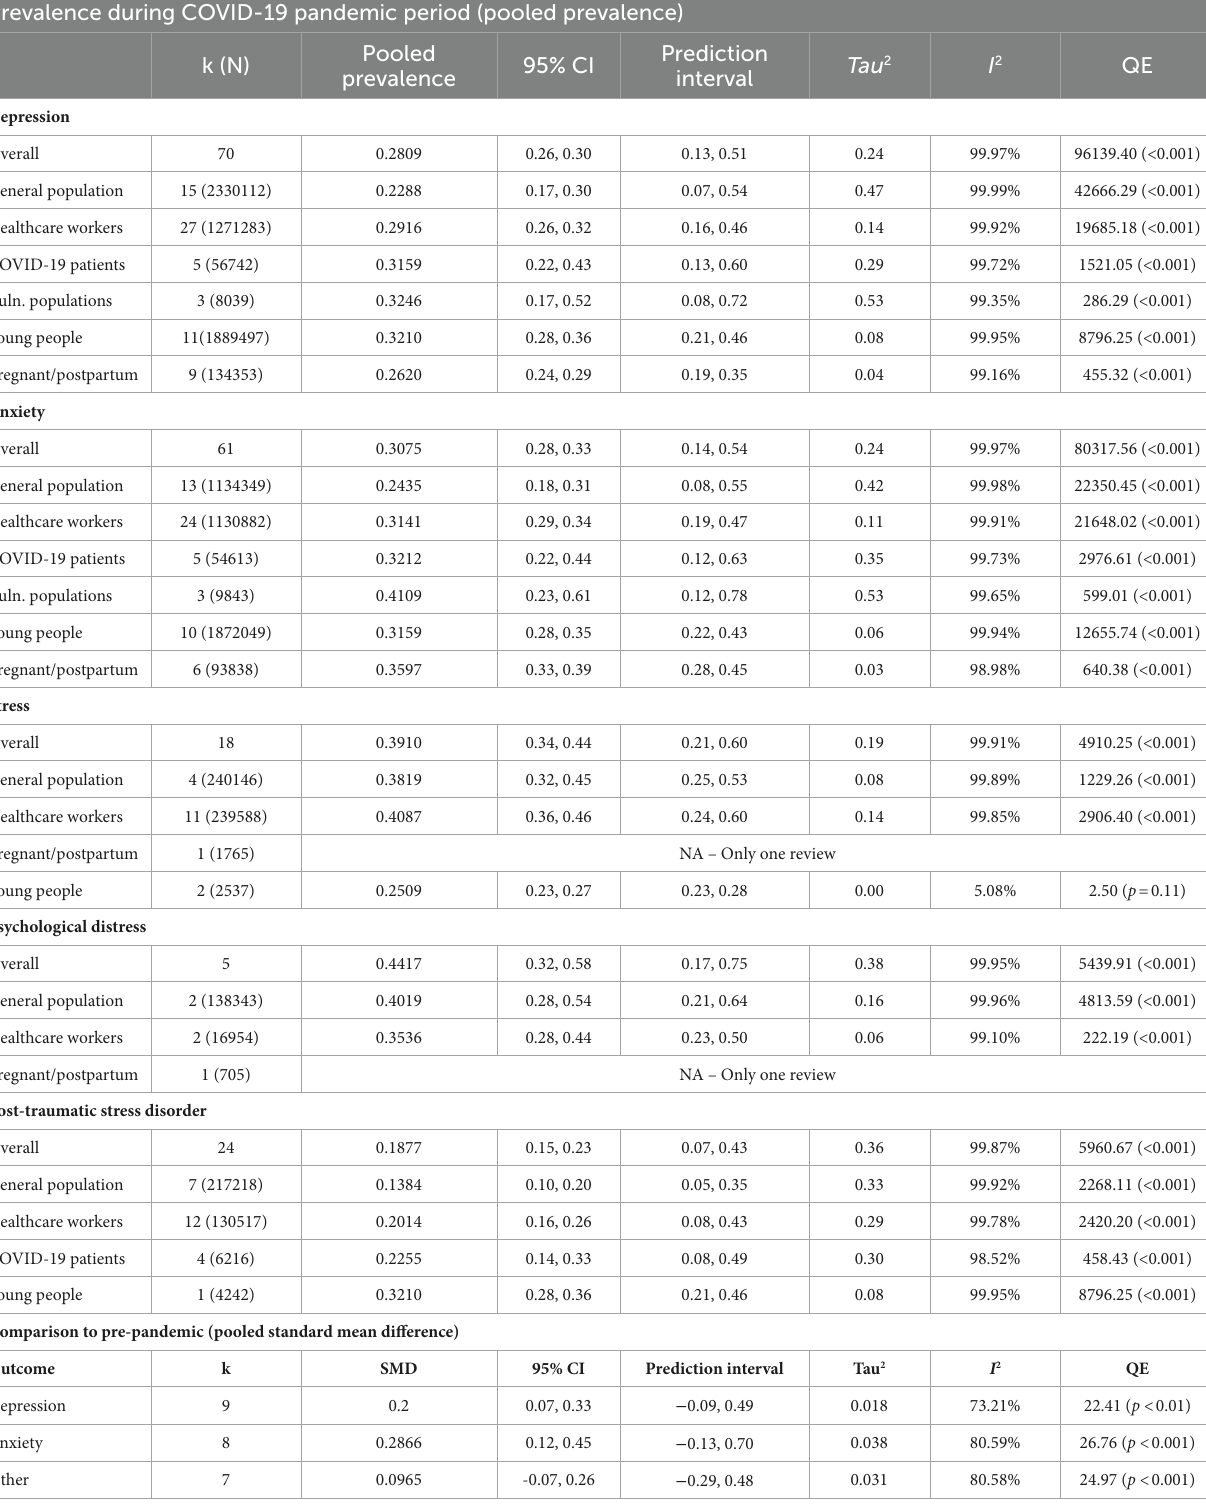
TABLE 1 Meta-review model summary and heterogeneity statistics for all models of probable depression, anxiety, stress, psychological distress, and post-traumatic stress disorder during the COVID-19 pandemic, including pooled prevalence and standardised mean difference. Prevalence during COVID-19 pandemic period (pooled prevalence) Pooled k (N)